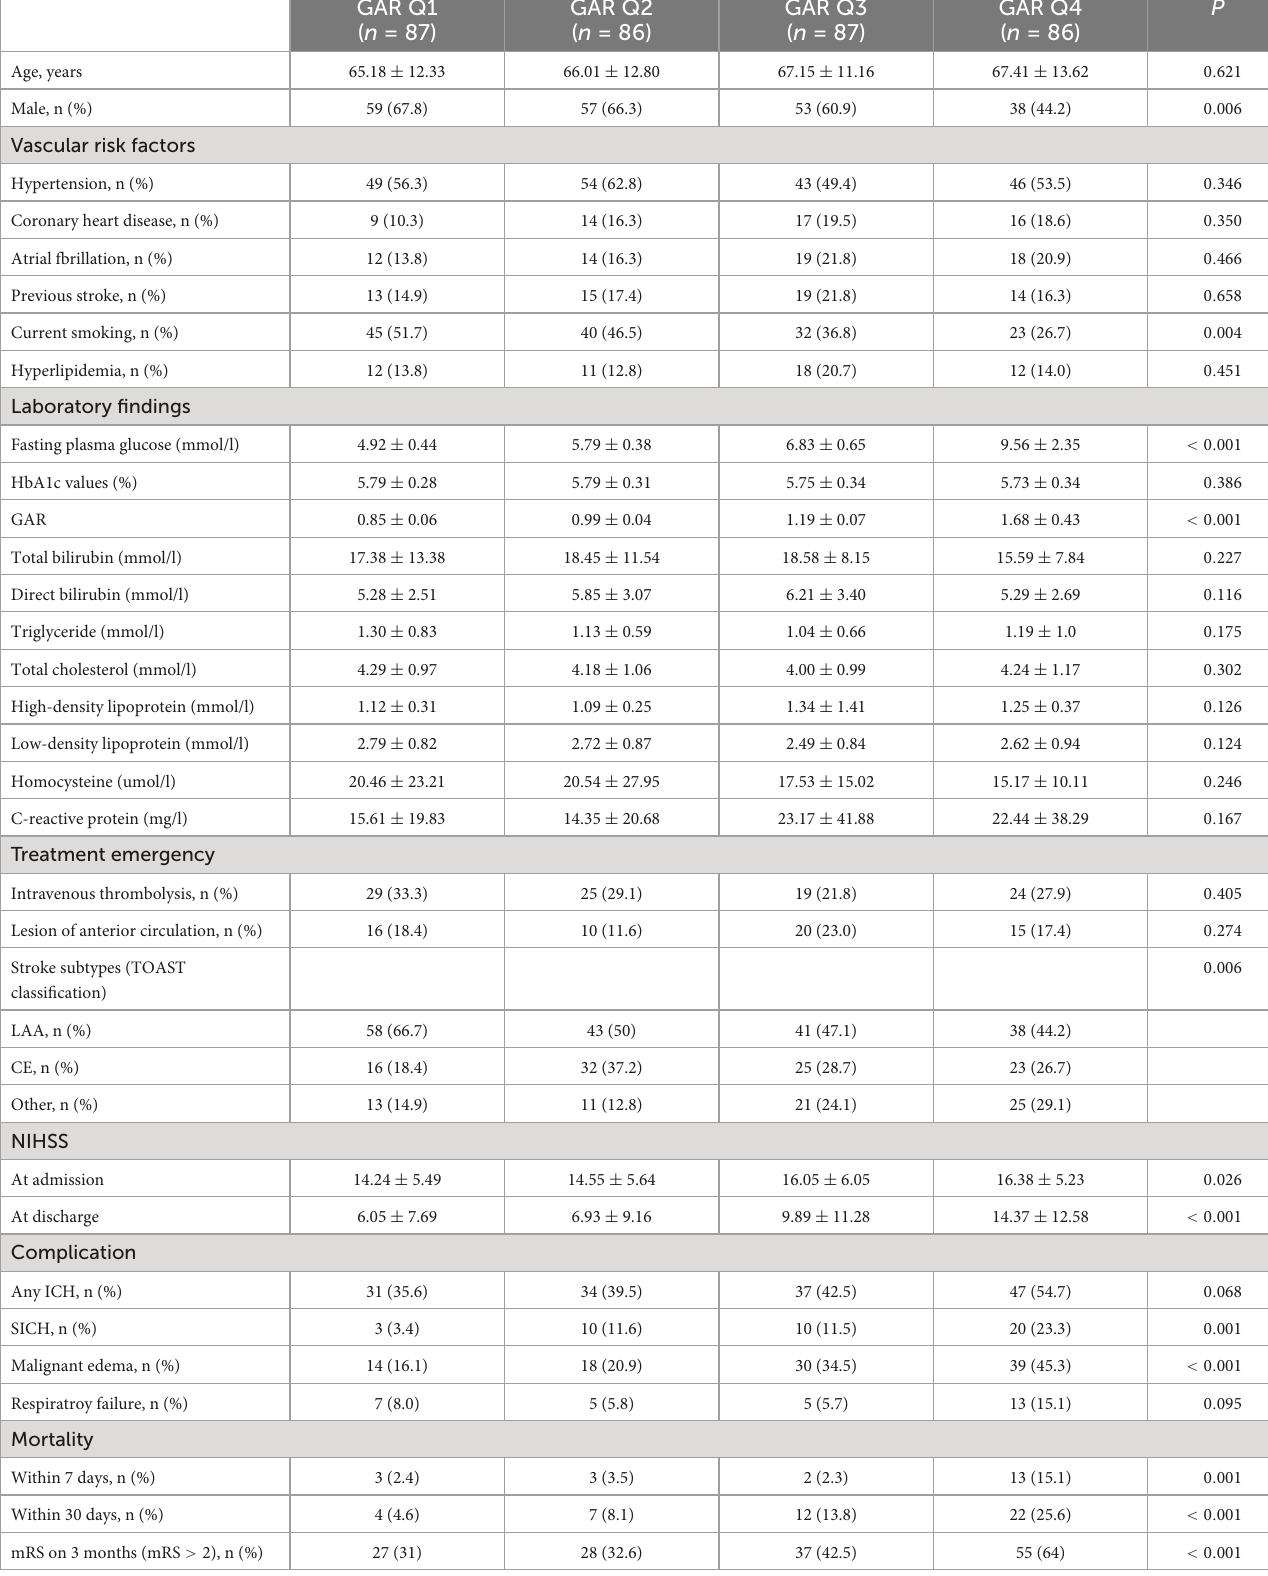
TABLE 2 Demographics, clinical data, complications and functional outcomes of non-diabetic